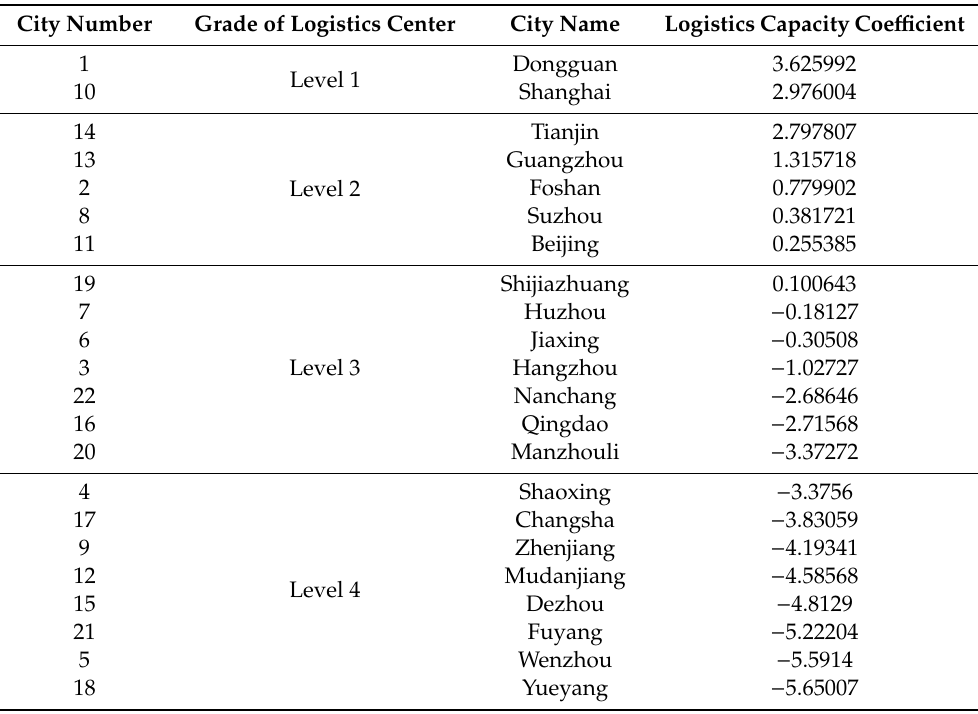
Table 13. Grade setting of the city logistics